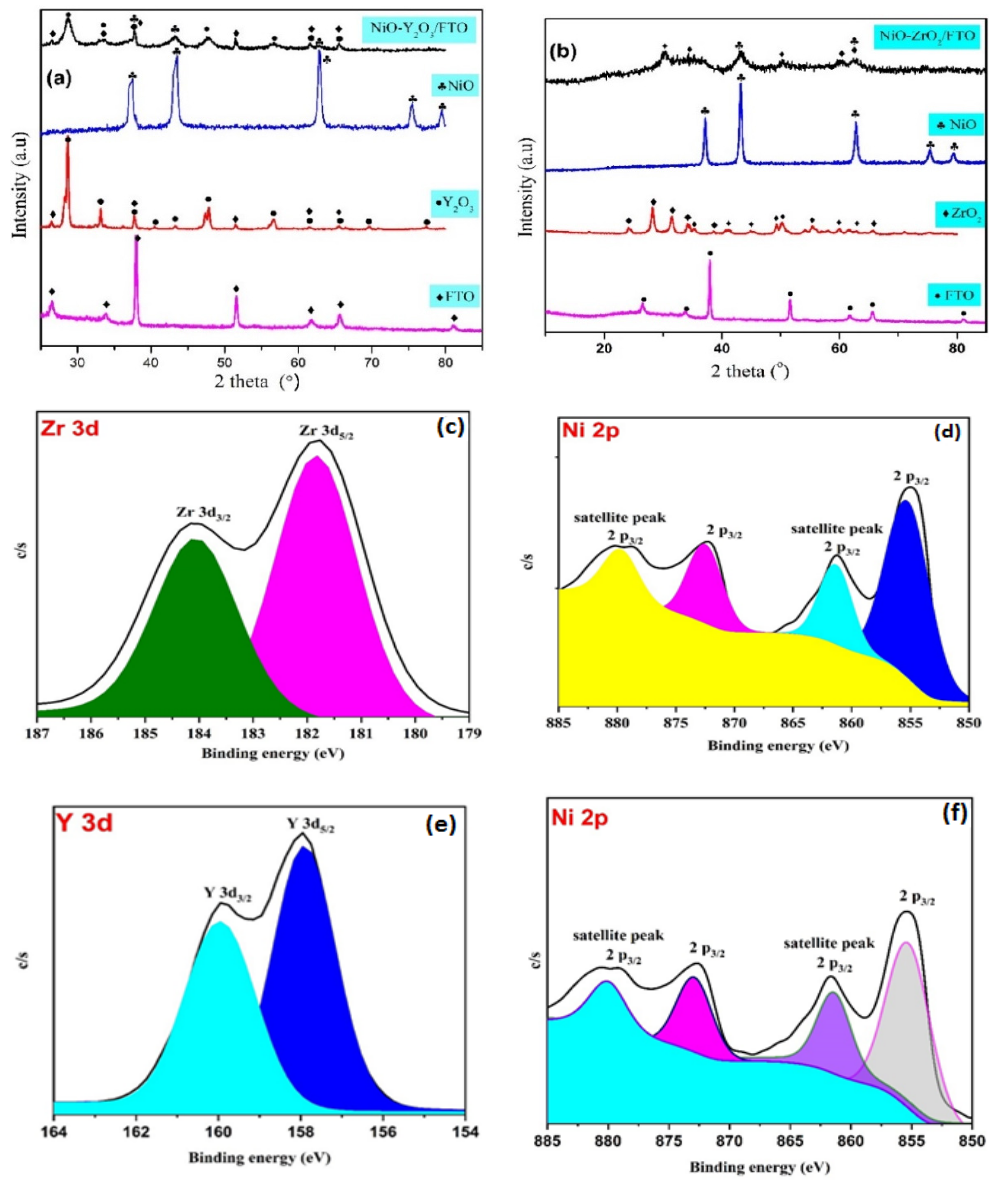
Figure 1. ( a ) XRD pattern of a) NiO/FTO, Y 2 O 3 /FTO and NiO-Y 2 O 3 /FTO thin film and ( b ) NiO/FTO, ZrO 2 /FTO, and NiO-ZrO 2 /FTO thin film, ( c , d ) are narrow scans for Zr 3d and Ni 2p for NiO– ZrO 2 /FTO thin film and ( e , f ) are narrow scan for Y 3d and Ni 2p for NiO- Y 2 O 3 /FTO thin film.